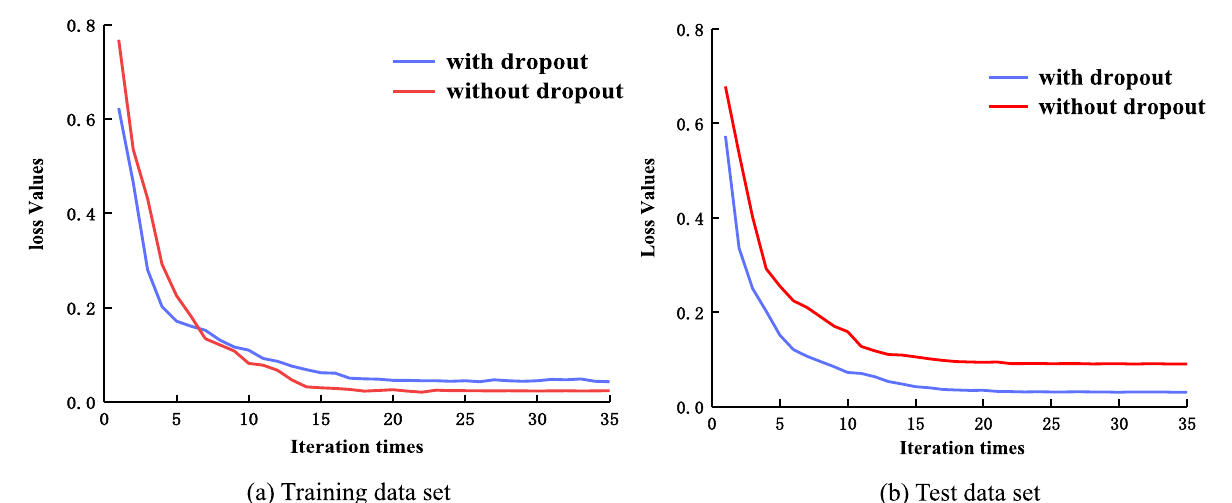
Fig. 5 Learning curve on the IEEE 39-bus